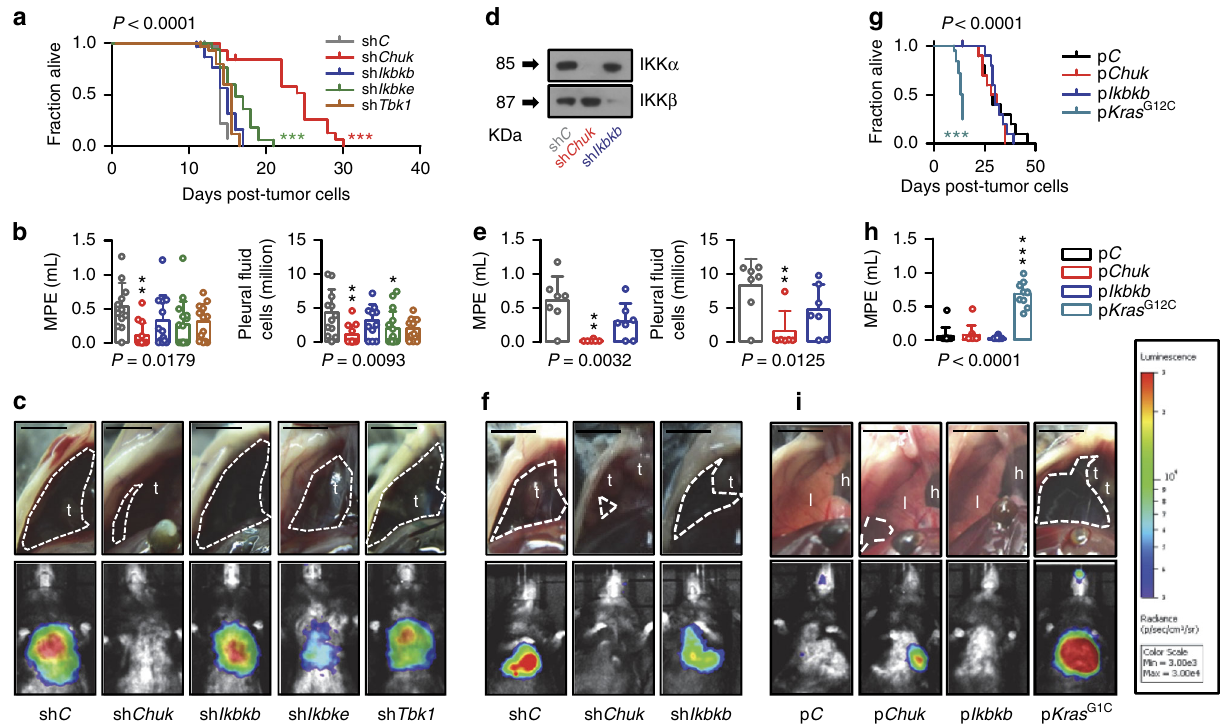
Fig. 6 IKK α is required for mutant KRAS -induced malignant pleural effusion. a – c Malignant pleural disease induced by LLC cells ( Kras G12C ) stably expressing p NGL NF- κΒ reporter and control shRNA (sh C ) or shRNA targeting IKK α (sh Chuk ), ΙΚΚβ (sh Ikbkb ), ΙΚΚε (sh Ikbke ), or TBK1 (sh Tbk1 ) transcripts ( n is given in Table 3). Shown are Kaplan – Meier survival plot ( a ), data summaries of effusion volume and pleural fl uid cells ( b ), and representative images of effusions (dashed lines) and pleural tumors (t) as well as bioluminescent images at day 13 after pleural injections of the indicated tumor cells ( c ). d – f Malignant pleural disease induced by MC38 cells ( Kras G13R ) stably expressing p NGL NF- κΒ reporter and sh C , sh Chuk , or sh Ikbkb ( n is given in Supplementary Table 3). Shown are immunoblots of cytoplasmic extracts ( d ), data summaries of effusion volume and pleural fl uid cells ( e ), and representative images of effusions (dashed lines) and pleural tumors (t) as well as representative bioluminescent images at day 13 after pleural injections of the indicated tumor cells ( f ). g – i Malignant pleural disease induced by PANO2 cells ( Kras WT ) stably expressing p NGL NF- κΒ reporter and control plasmid (sh C ) or plasmid encoding IKK α (p Chuk ), ΙΚΚβ (p Ikbkb ), or mutant (p Kras G12C ) transcripts ( n is given in Supplementary Table 3). Shown are Kaplan – Meier survival plot ( g ), data summary of effusion volume ( h ), and representative images of effusions (dashed lines) and pleural tumors (t), hearts (h), and lungs (l), as well as representative bioluminescent images at day 14 after pleural injections of the indicated tumor cells ( i ). Data are presented as mean ± s.d. P , probability of no difference between cell lines by overall log-rank test ( a , g ) or one-way ANOVA ( b , e , h ). ns, single, double, and triple asterisks (*, **, and ***): P > 0.05, P < 0.05, P < 0.01, and P < 0.001, respectively, for the indicated comparisons with control cells by Bonferroni post-tests. Scale bars, 0.5